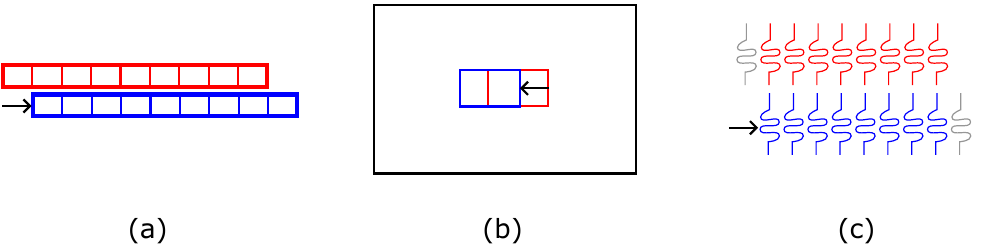
Figure 4. ( a ) Assuming low decorrelation over small displacements, motion of the array (here by one element pitch) can be estimated using a cross-correlation search between plane wave transmissions. ( b ) Speckle tracking uses a 1-D search of an image kernel between a reference and target image over a field of view relative to each array position. ( c ) Channel correlation compares shifted pairs of raw channel signals with varying offsets, reducing the active subaperture with increasing